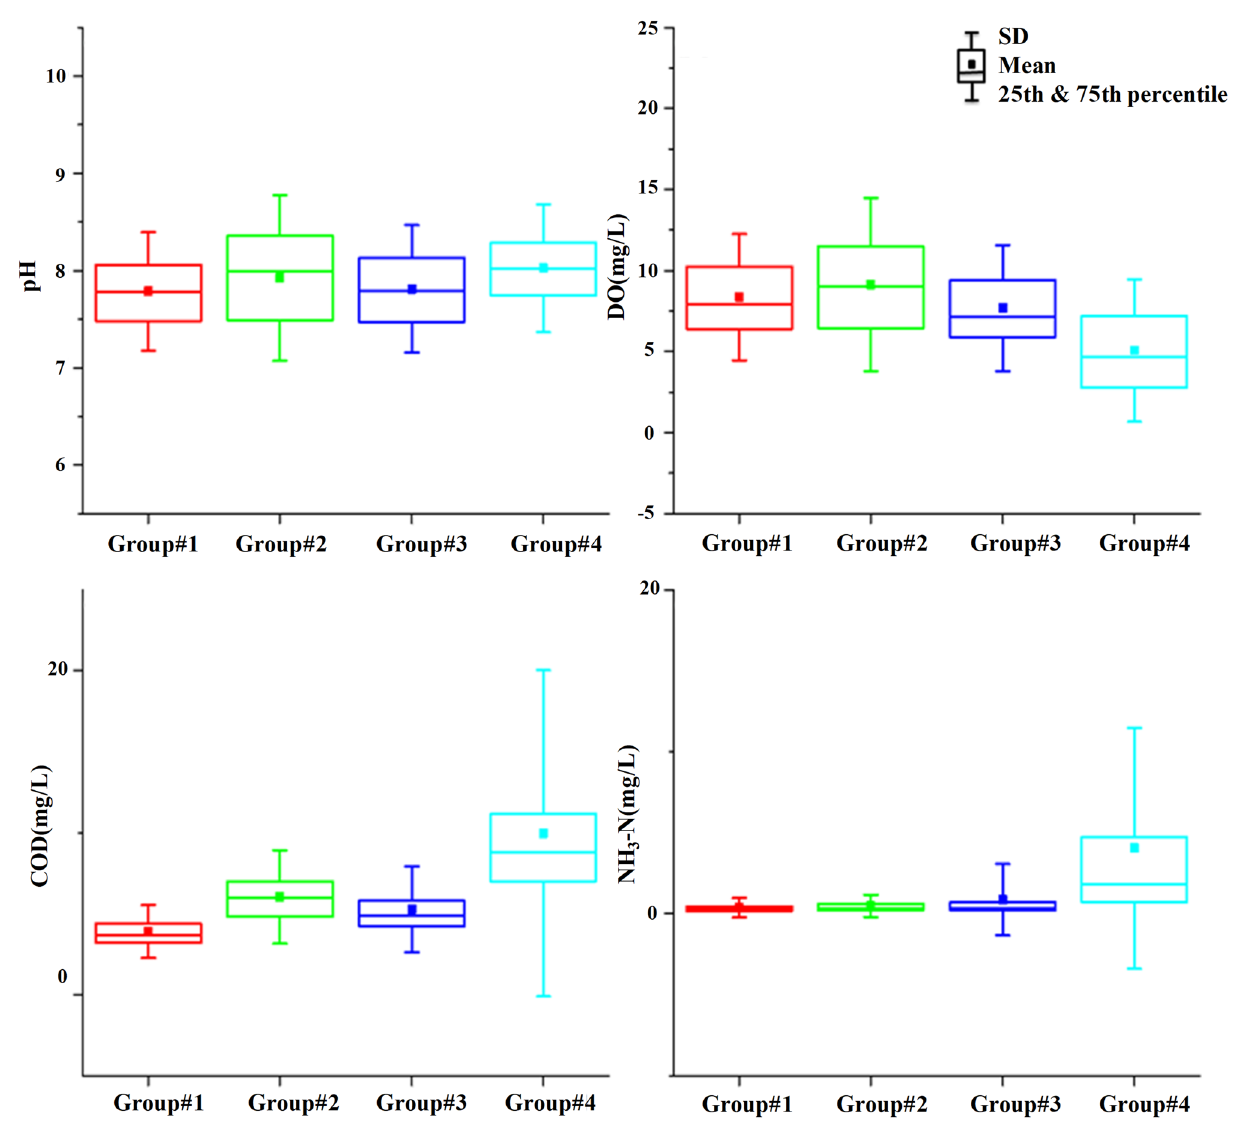
Fig. 7 Groupwise spatial variations of water quality for Huaihe River